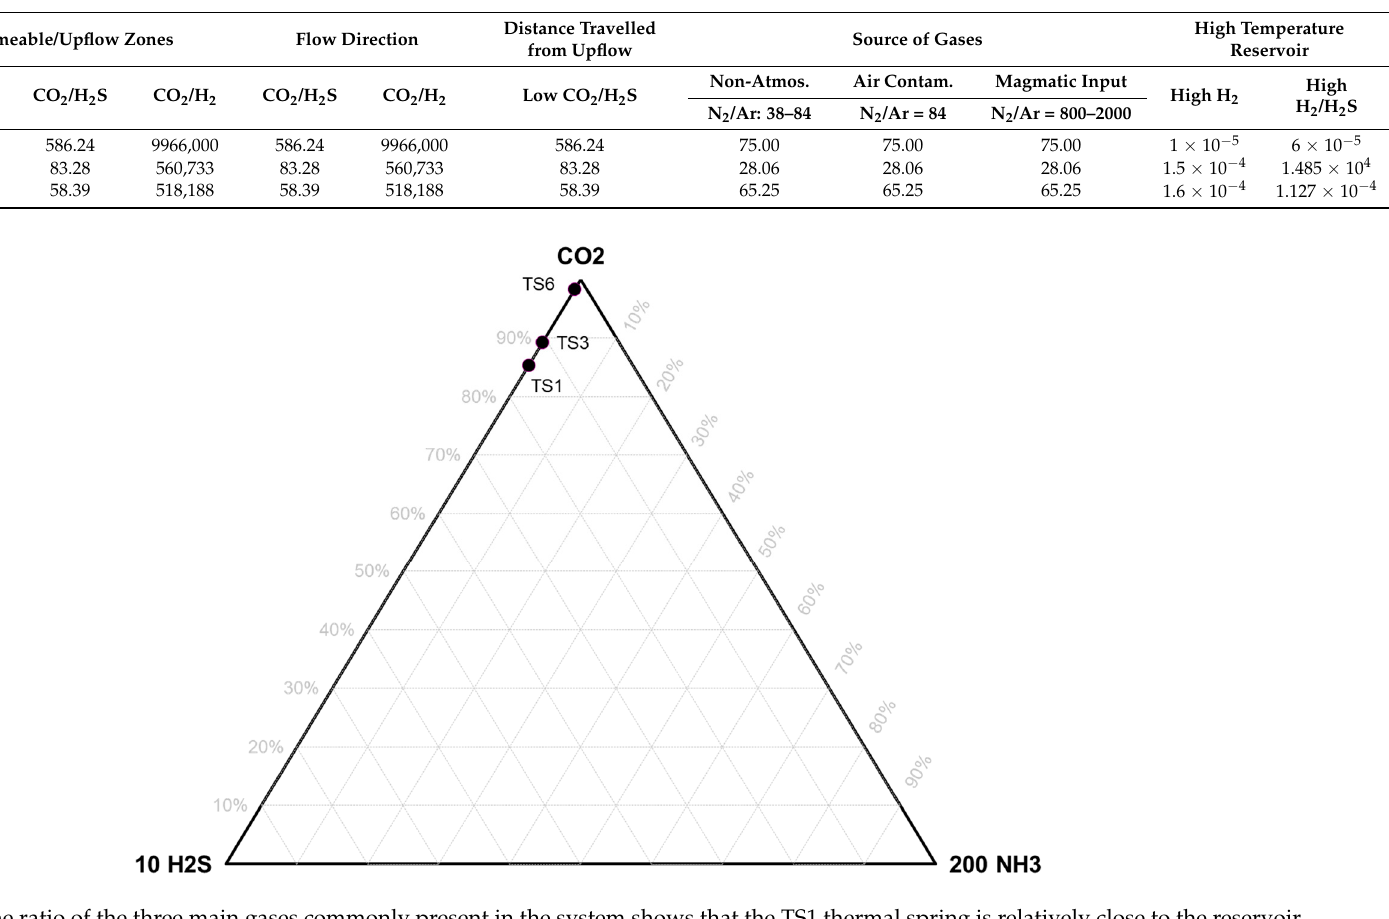
Figure 13. The ratio of the three main gases commonly present in the system shows that the TS1 thermal spring is relatively close to the reservoir.